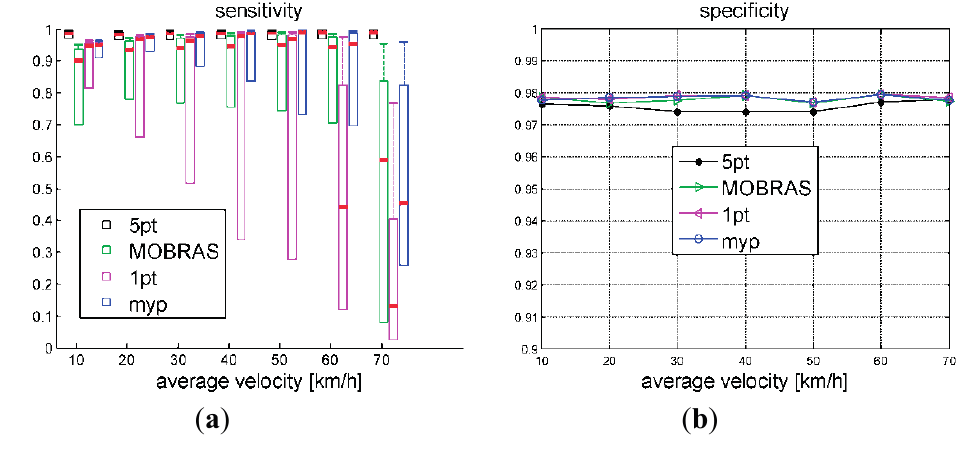
Figure 9. Sensitivity and specificity of true inliers detection vs. vehicle velocity. Outlier percentage is set to